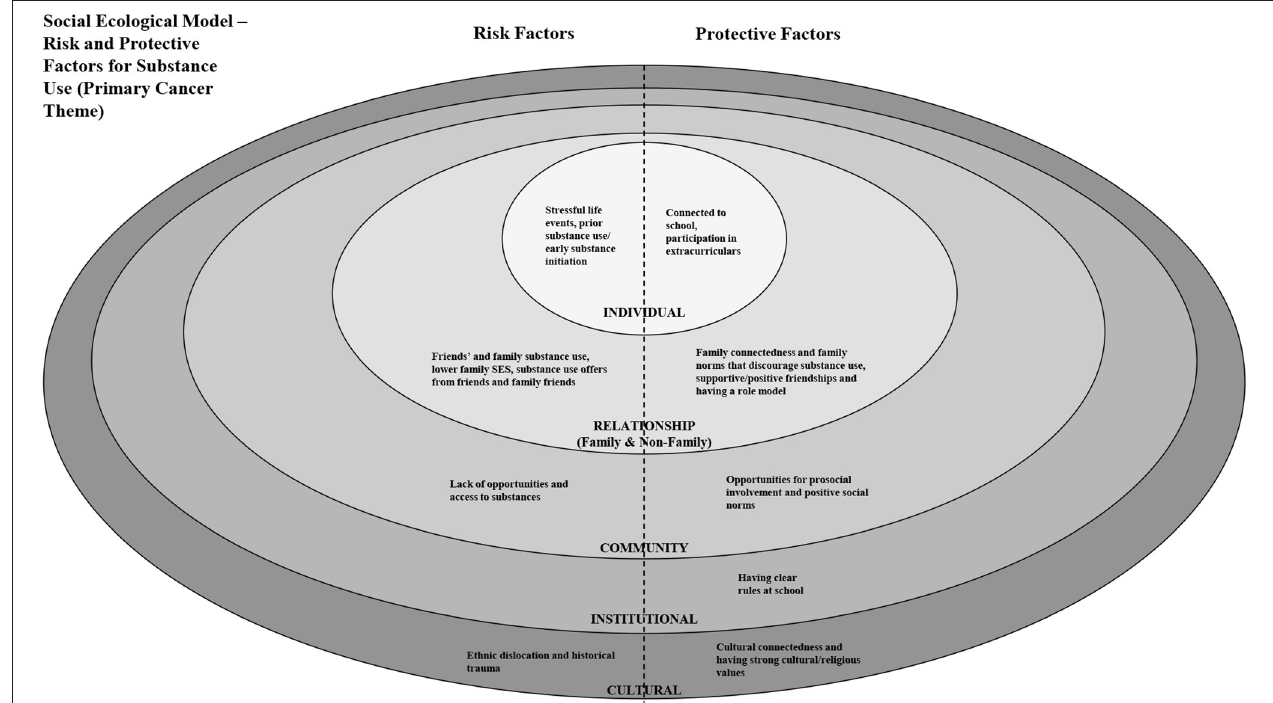
FIGURE 3 | Social ecological model - risk and protective factors for substance use (primary cancer